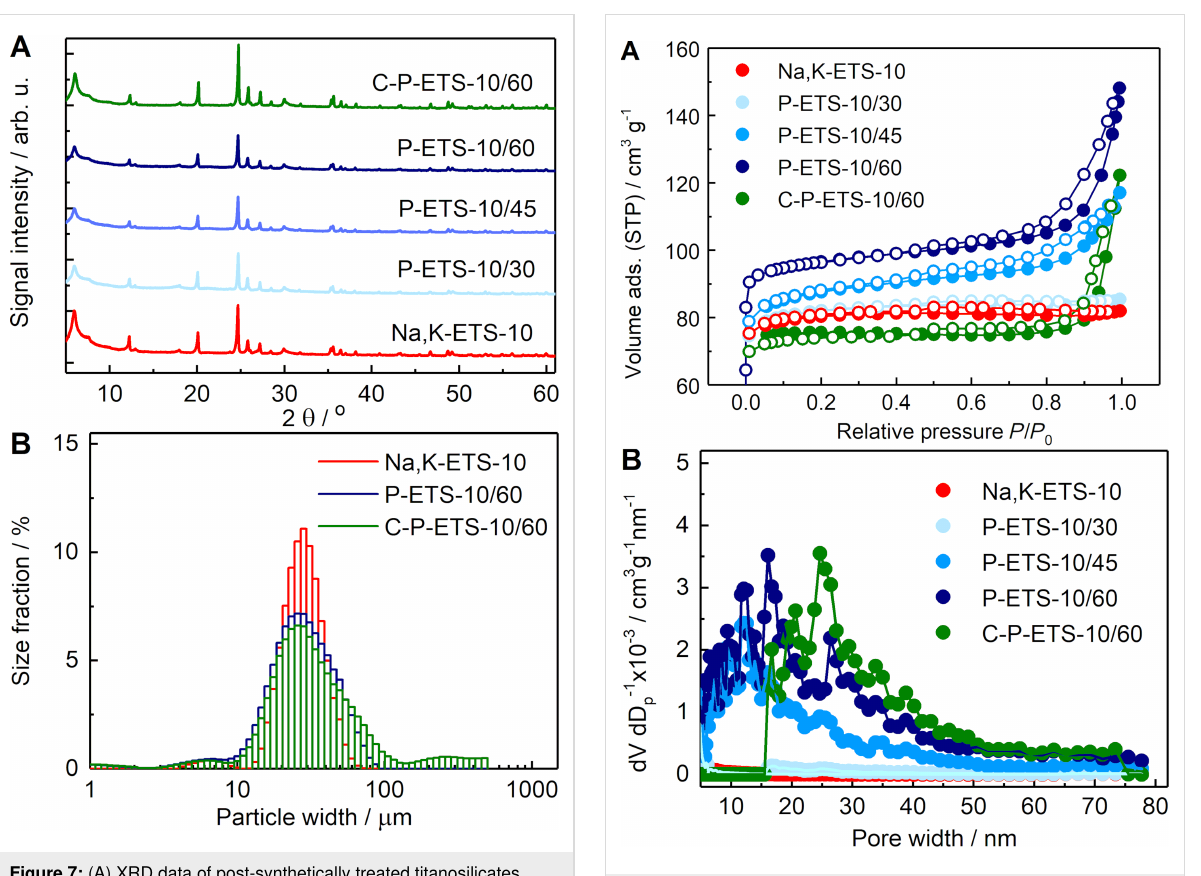
slightly increases from 0.110 cm 3 g − 1 for the parent titanosili- cate to 0.131 cm 3 g − 1 after 60 min of treatment. The applica- tion of calcination has led to a slightly lower mesopore volume for P-ETS-10/60 (0.098 cm 3 g − 1 ) and C-P-ETS-10/60 (0.084 cm 3 g − 1 ) and to micropore volumes of 0.131 cm 3 g − 1 and 0.105 cm 3 g − 1 , respectively. Referring to the XRD data, which reveals that the structure of the ETS-10 material after